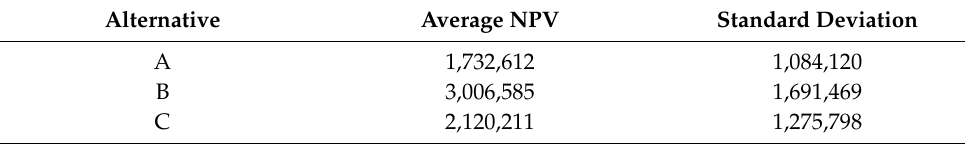
Table 4. Mean and variability of the simulated NPV values for each